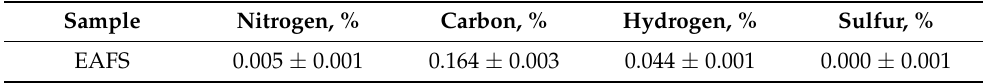
Table 1. Elemental analysis of the electric arc furnace